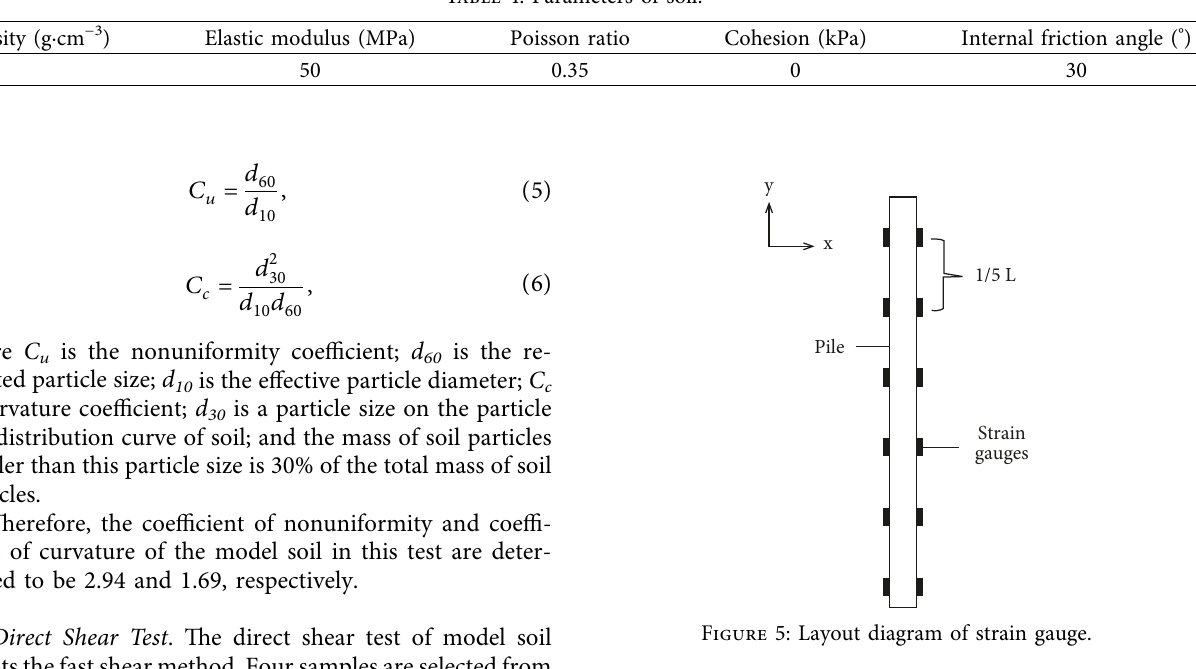
Figure 5: Layout diagram of strain